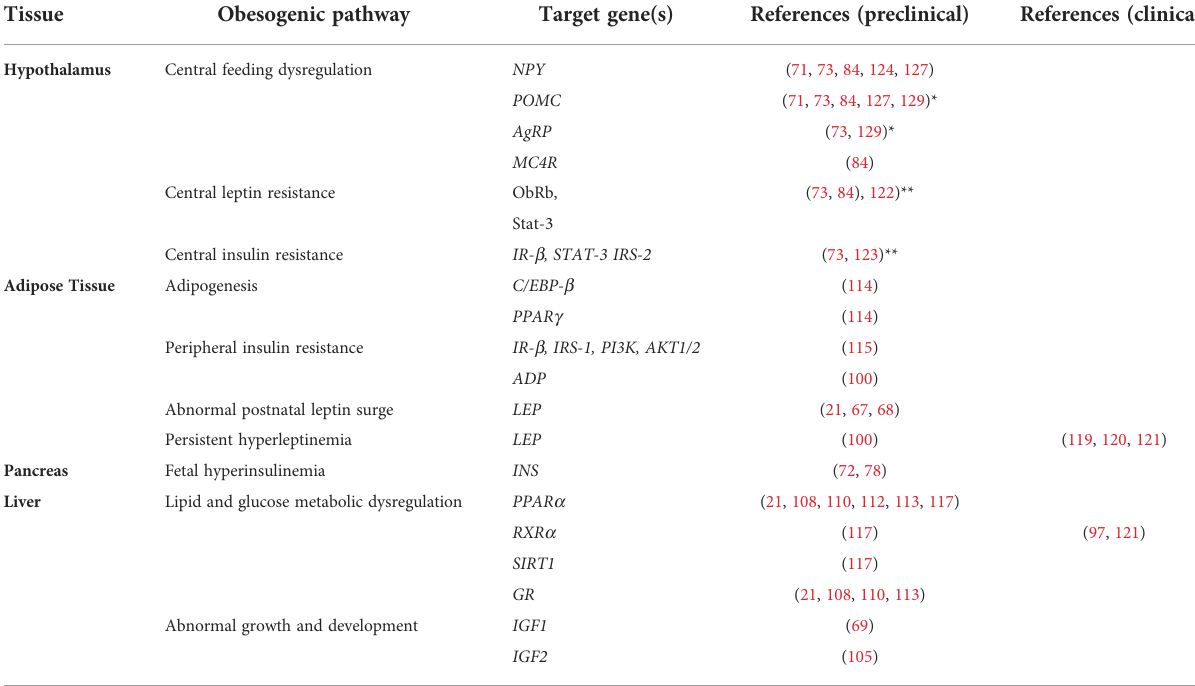
TABLE 1 Tissue-speci fi c pathways and genes involved in the metabolic programming of obesity.